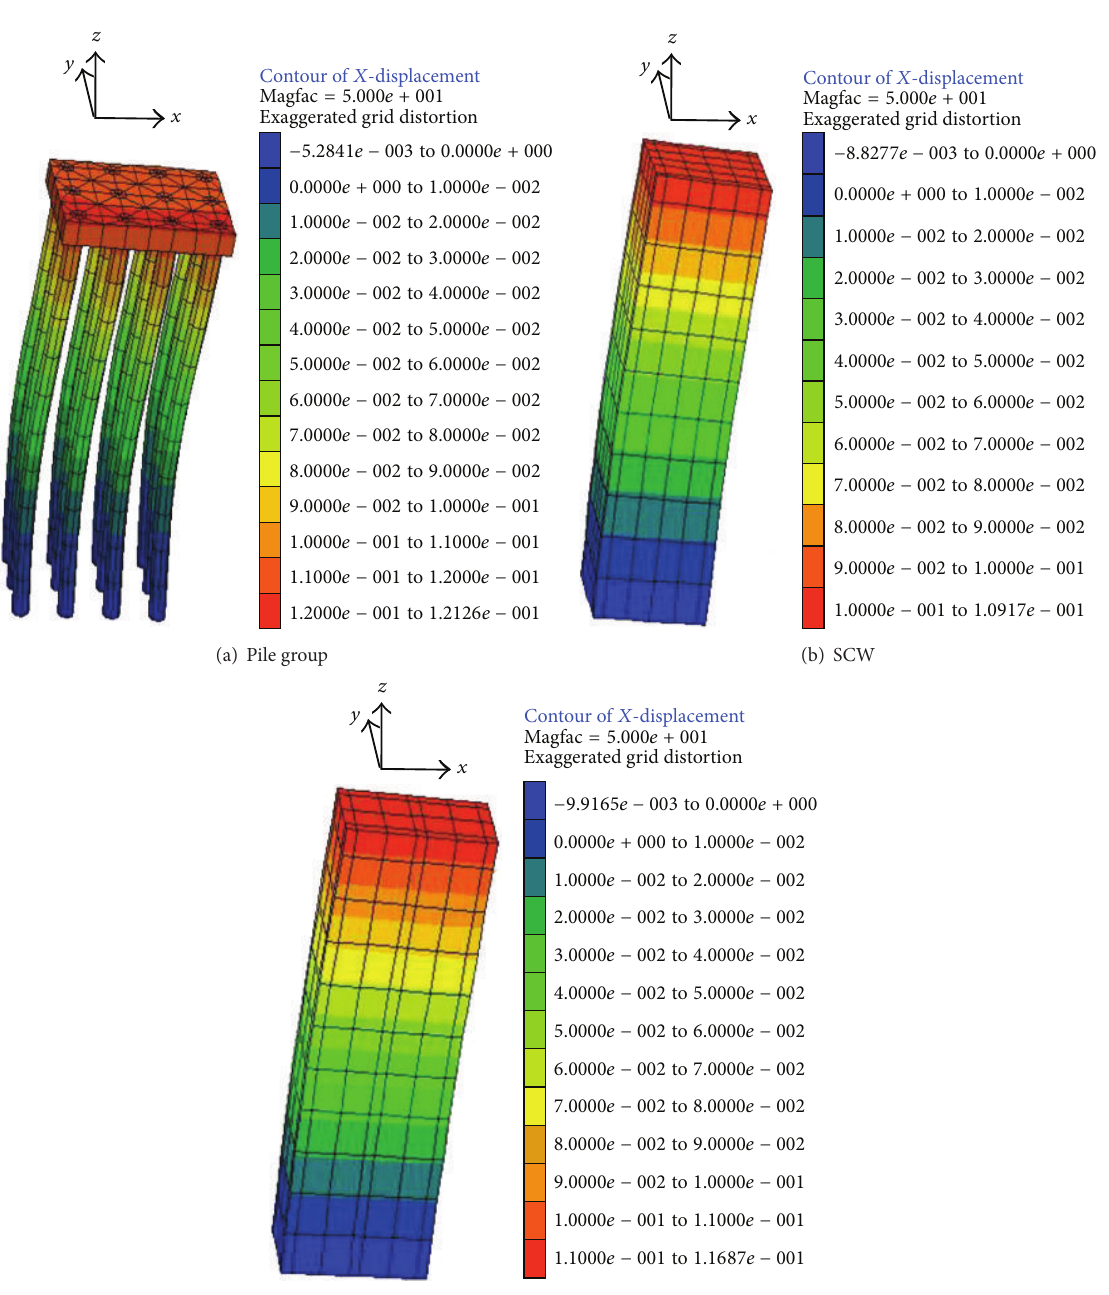
Figure 10: Deformation graphs of three models (magnification factor: 50